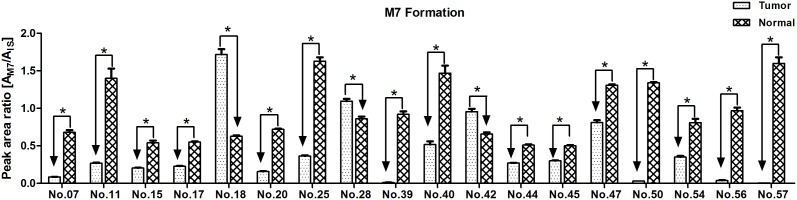
Inter-individual variability of sorafenib metabolism by UGT1A9 with 18 human liver microsomes samples (THLMs and NHLMs).Sorafenib (2.5 µM) was incubated with microsomes (0.133 mg/ml) obtained from different patients for 90 min at 37°C. The formation rate of M7 expressed as peak area ratio (mean ± SD). All the experiments were performed in triplicate. Student’s T-test analysis was used for data analysis. “*” denotes statistical significance (P<0.05).